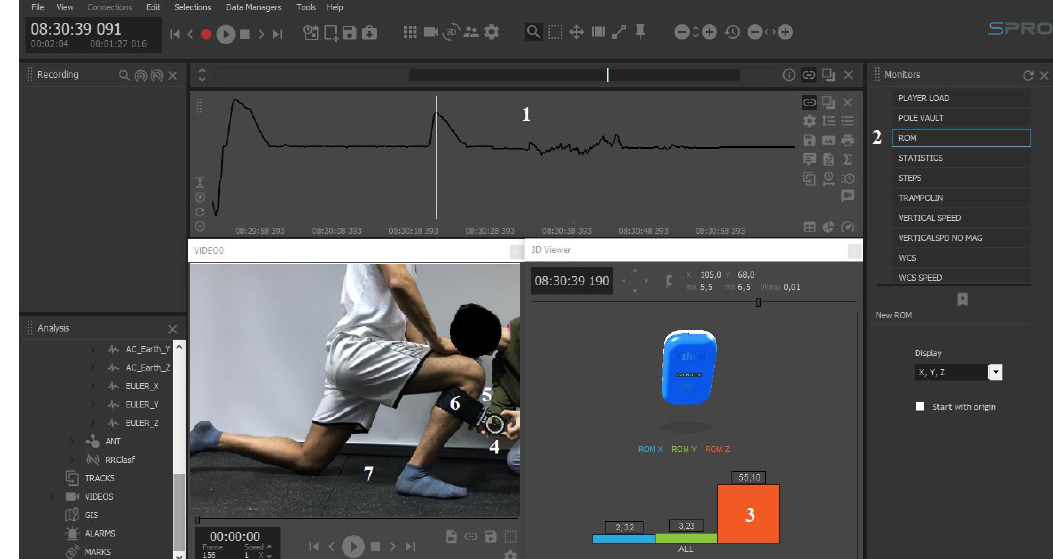
Figure 2. Description of SPro software interface. 1: raw data from the Euler Z channel collected by WIMU Pro; 2: ROM application available on Monitors panel; 3: range of motion registered in ankle dorsiflexion movement; 4: inclinometer; 5: WIMU Pro under the inclinometer; 6: elastic fixing band; 7: video recording of the experimental setting synchronized with the data.